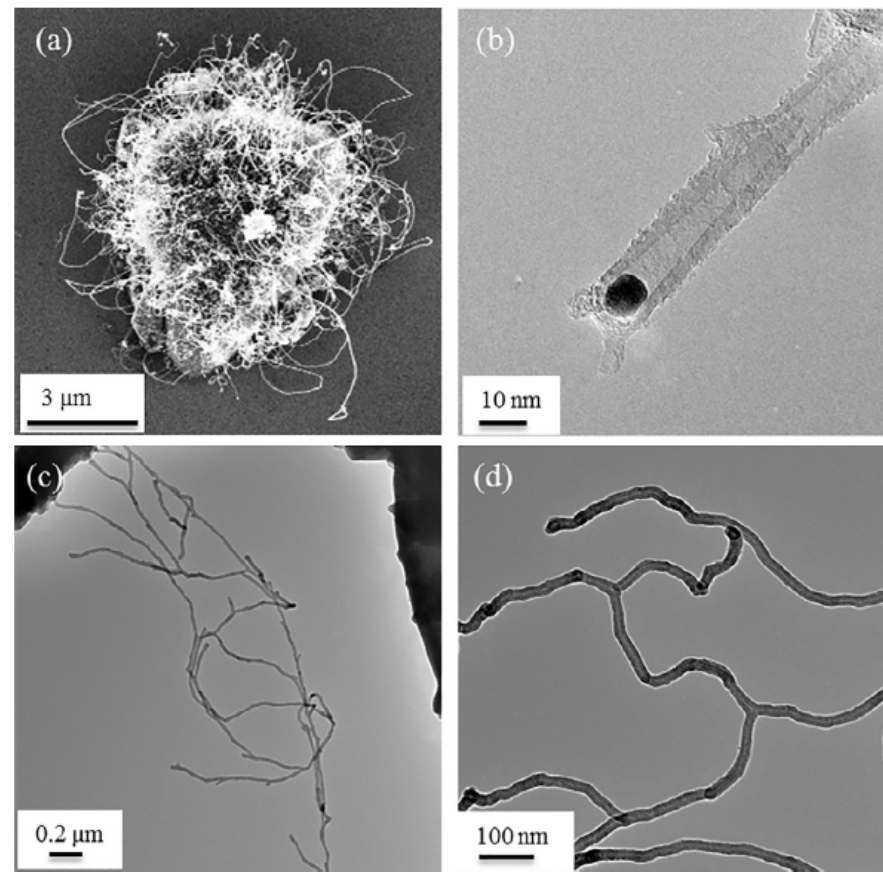
Figure 9. Micrographs of the magnetite NPs and formed b-MWNTs: ( a ) SEM overview of CNTs growing from pumice; ( b ) TEM detail of nucleating Fe 3 O 4 NP; ( c ) TEM overview of b-MWNTs; ( d ) TEM detail of b-MWNTs. Reproduced from [116] , Copyright© 2018, with permission from Elsevier.